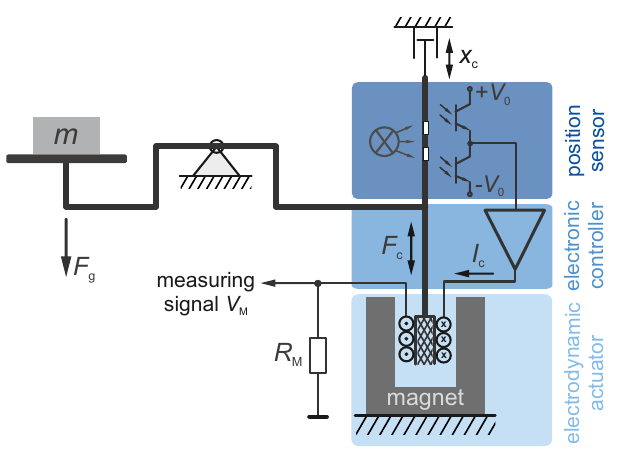
Figure 2. Basic principle of an electrodynamic precision balance according to Krause (2005) and S¸tefˇanescu